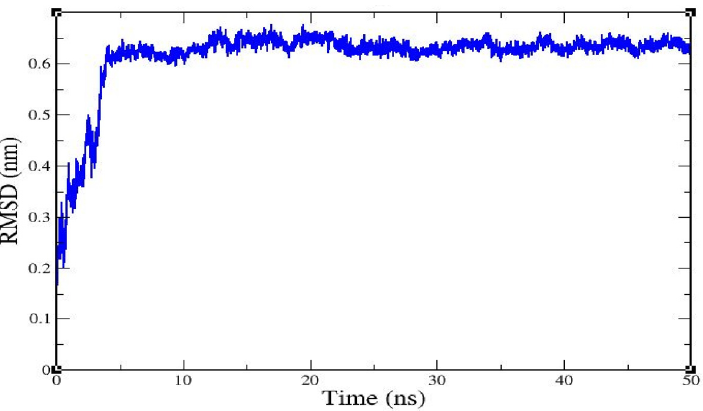
Figure 2. The root mean square deviation of caspase 8 / rutaecarpine as determined by molecular dynamics (MD) simulation.